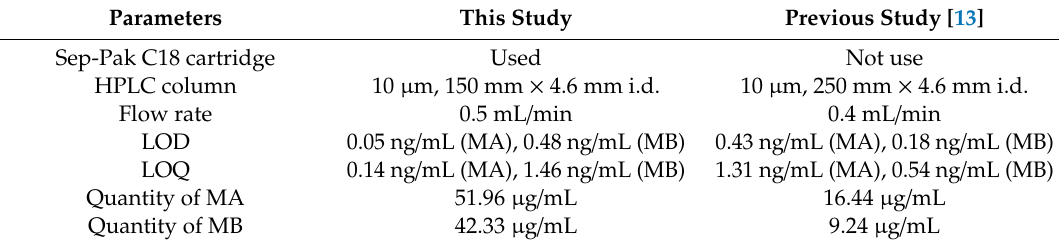
Table 4. Advanced development of the quantitative methods by HPLC for MA and MB. Parameters This Study Previous Study